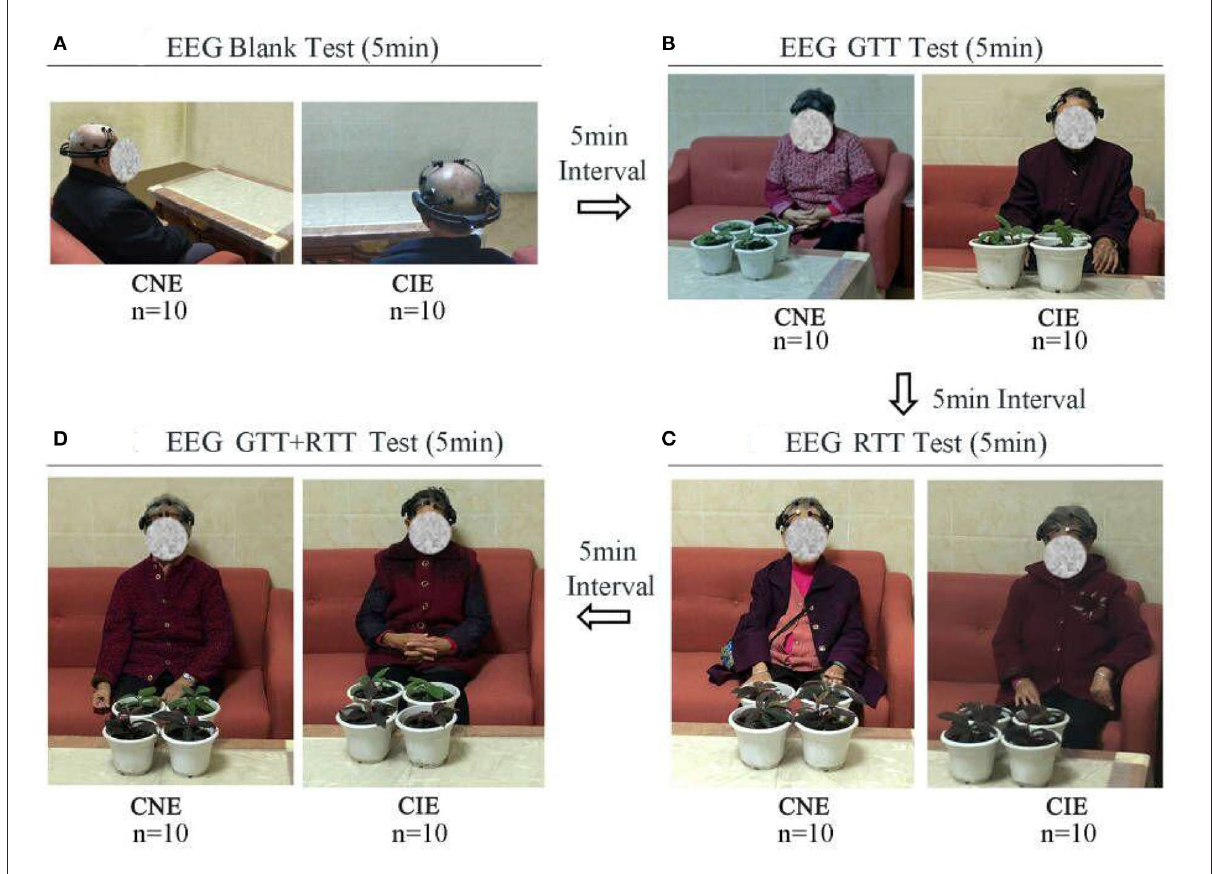
FIGURE3 Experimental